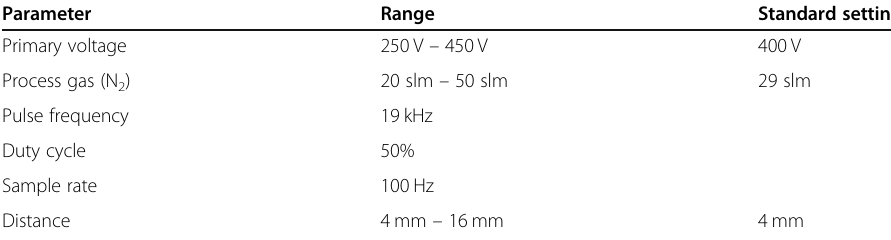
Table 1 Overview of the experimental parameters Parameter Range Standard